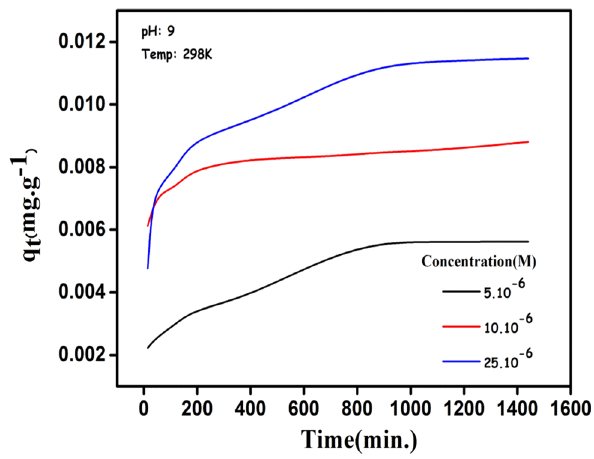
Fig. 1 The change of adsorption kinetics with different methylene blue concentration